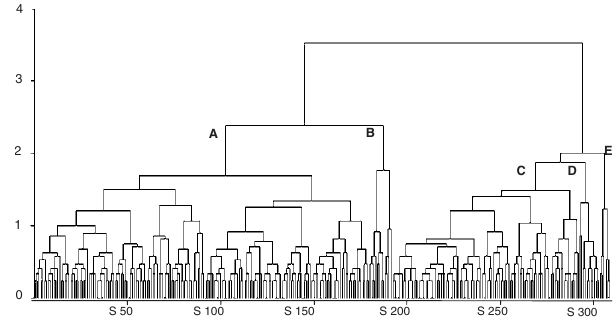
FIG. 11. A dendrogram for cluster analysis of 308 students. The horizontal axis represents 308 students (cid:1) S1–S308 (cid:2) ; the vertical axis represents the Euclidian distance among clusters. For instance, the distance between clusters A and B is the vertical height of the hori- zontal line connecting A and B , which reads approximately 2.4.